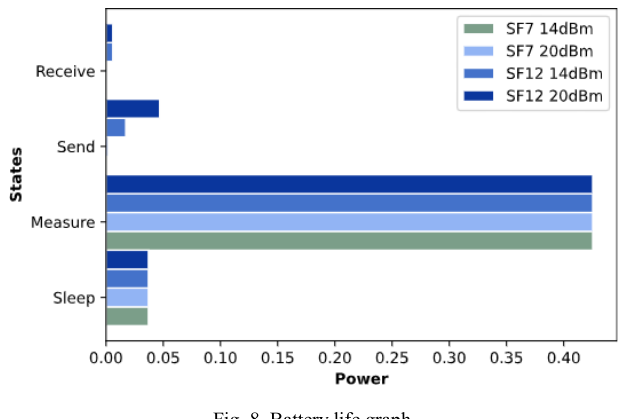
Fig. 8. Battery life graph